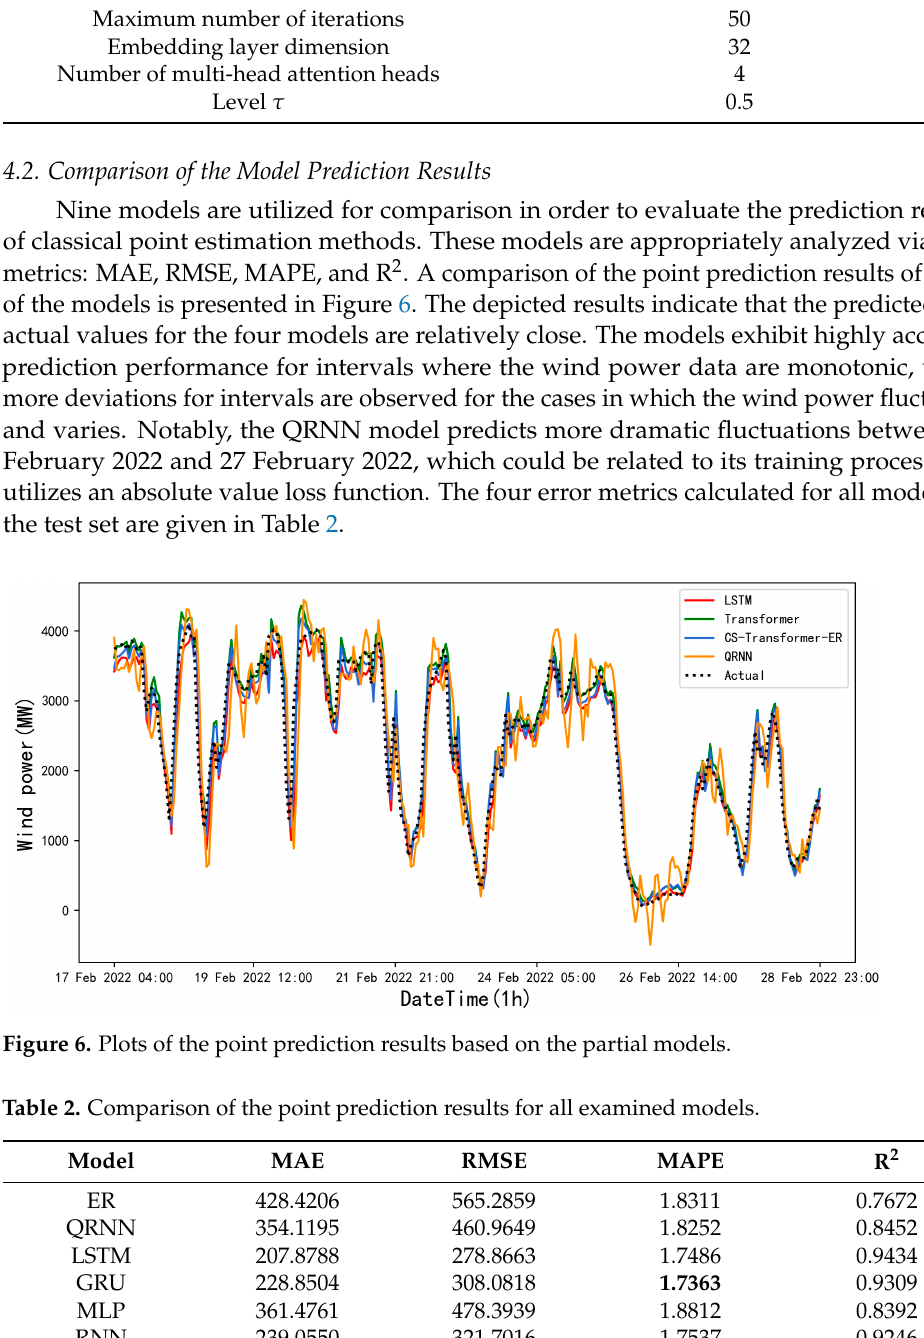
Figure 5. Wind power plot of aggregate Belgian wind farms from 1 January to 28 February 2022. Table 1. The main parameters of the NNMs.